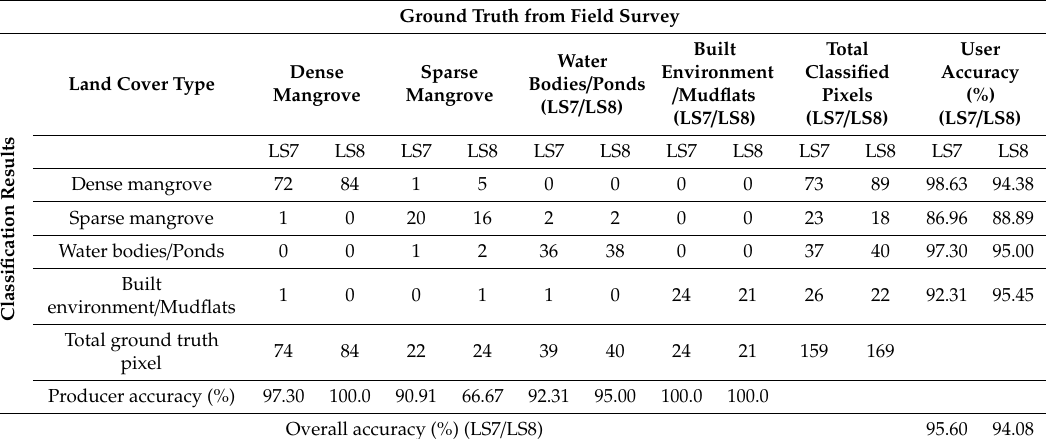
Table 3. Validation results of land use classification for Landsat-7 and